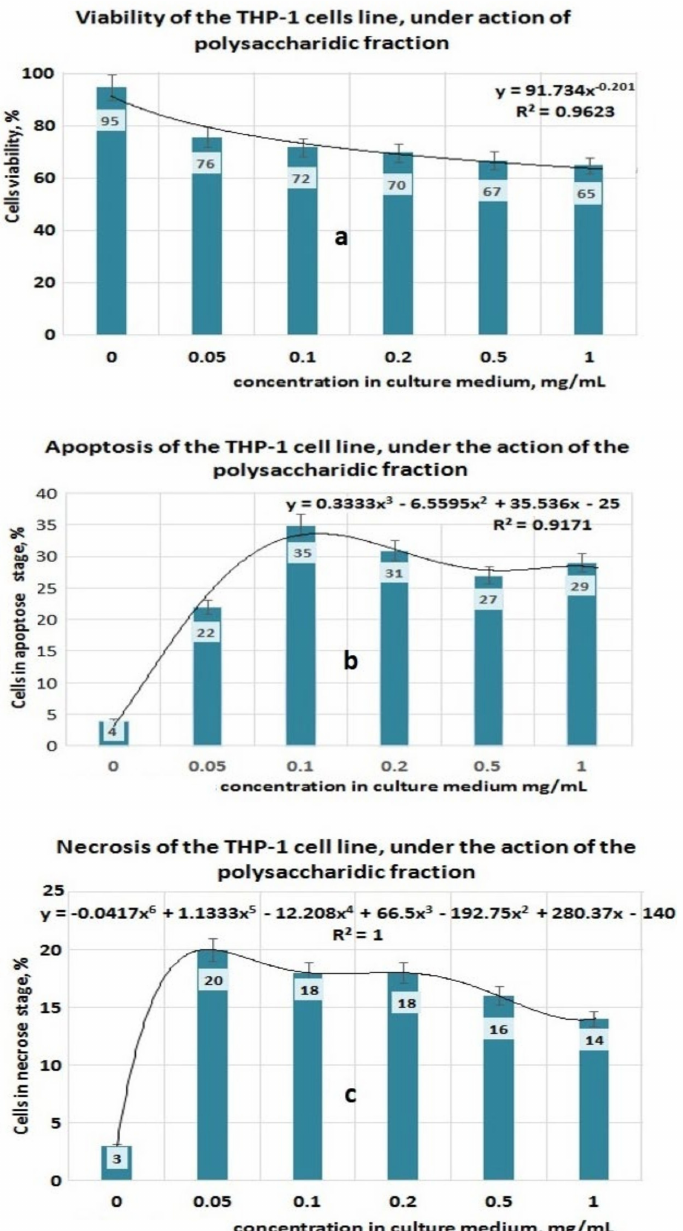
Figure 5. Effect of exposure at PP fraction on THP–1 cell lines. ( a ) Viability of THP–1 cell line under action of PP fraction; ( b ) Apoptosis of THP–1 cell line under action of PP fraction; ( c ) Necrosis of THP–1 cell line under action of PP